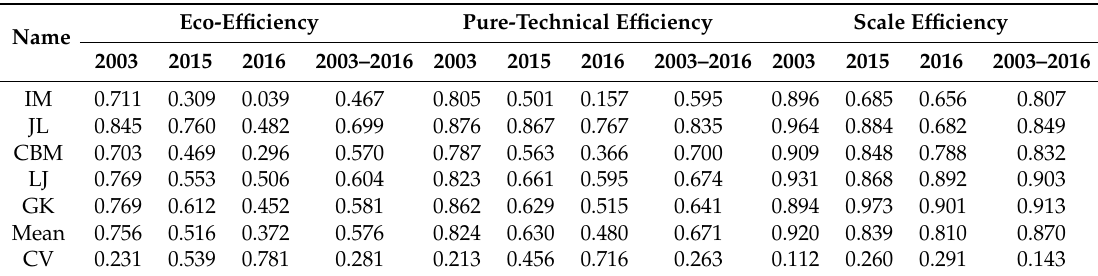
Table 3. Eco-efficiency of five SOFE